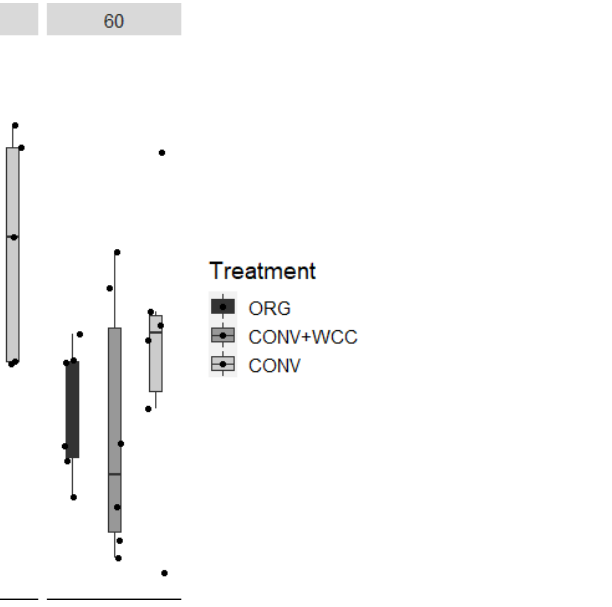
Figure A2. Mean weight diameter of aggregates obtained by wet sieving for 0–15, 15–60, and 60–100cm depth intervals in ORG, CONV + WCC, and CONV systems.